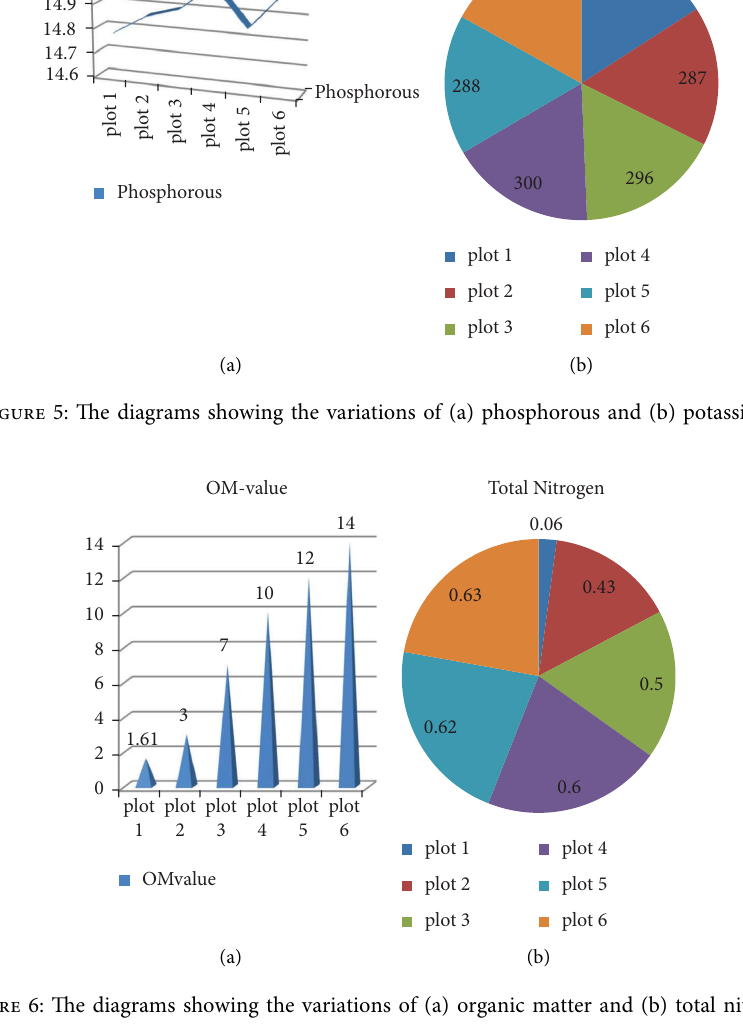
Figure 6: Te diagrams showing the variations of (a) organic matter and (b) total